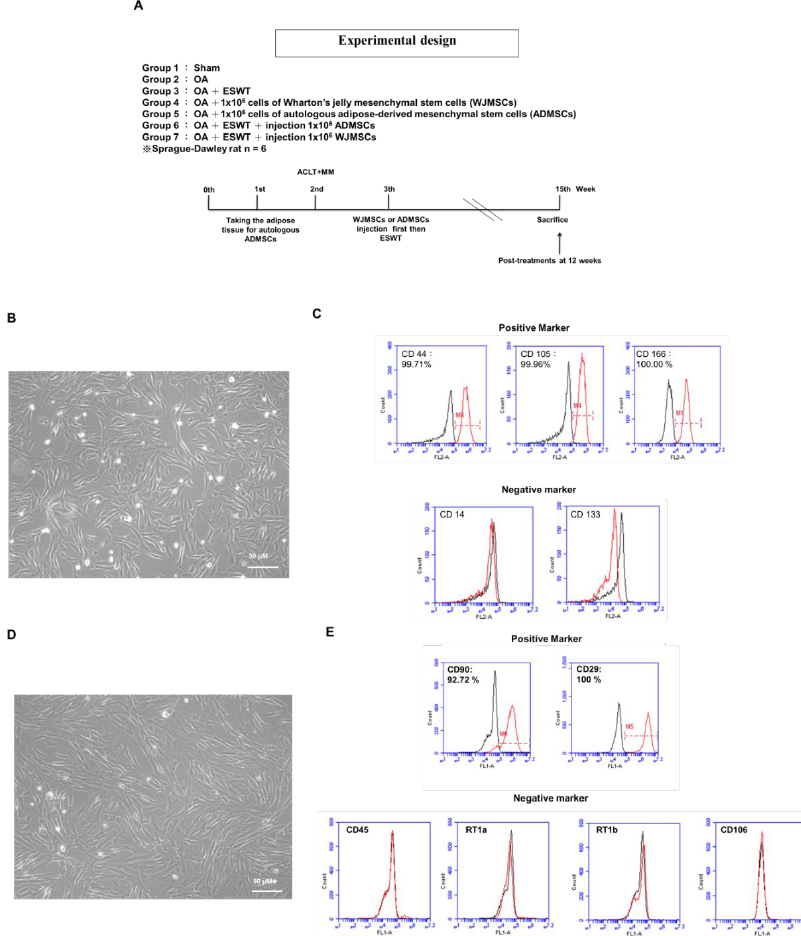
Figure 1. Study design and characterization of human WJMSCs and rat ADMSCs. ( A ) Graphic scheme depicting the study design of the experiment, including knee surgery, shockwave application, injection of Wharton’s jelly-derived mesenchymal stem cells (WJMSCs) or adipose-derived mesenchymal stem cells (ADMSCs), and sacrifice of animals. Six rats in each group were used in the experiments. ( B ) Morphology of cultured WJMSCs. ( C ) Analysis of cell-surface markers on WJMSCs. Cells were labeled with the indicated markers: CD44 (99.71%), CD105 (99.96%), and CD166 (100.00%) as positive markers; CD14 and CD133 as negative markers. ( D ) Morphology of cultured rat ADMSCs. ( E ) Analysis of cell-surface markers on rat ADMSCs. Cells were labeled with the indicated markers: CD90 (92.72%) and CD29 (100.00%) as positive markers; CD45, RT1a, RT1b, and CD106 as negative markers. The percentage is shown as the red line; the black line represents isotype